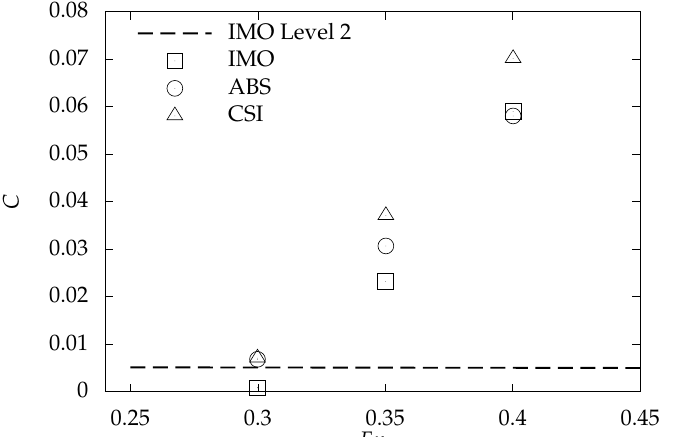
Figure 25. Level 2 surf-riding and broaching assessment for fishing vessel test case at various Froude